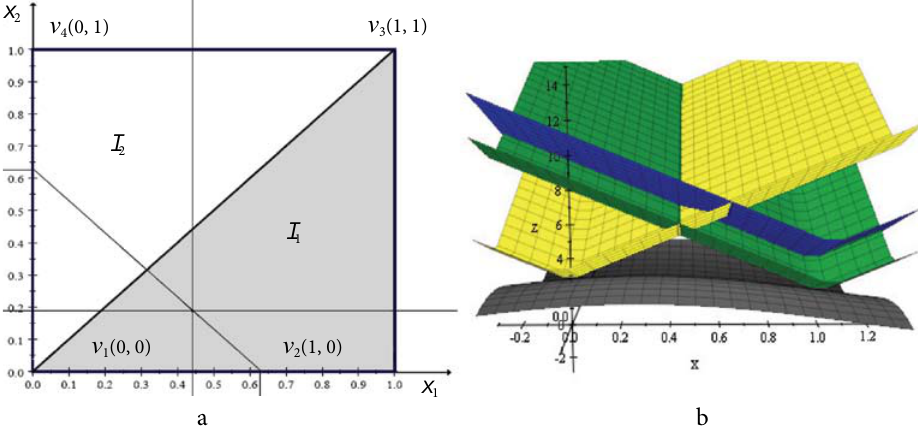
Fig. 1. Projection of intersection lines (a); visualization of upper bounding functions with the first norm (b)